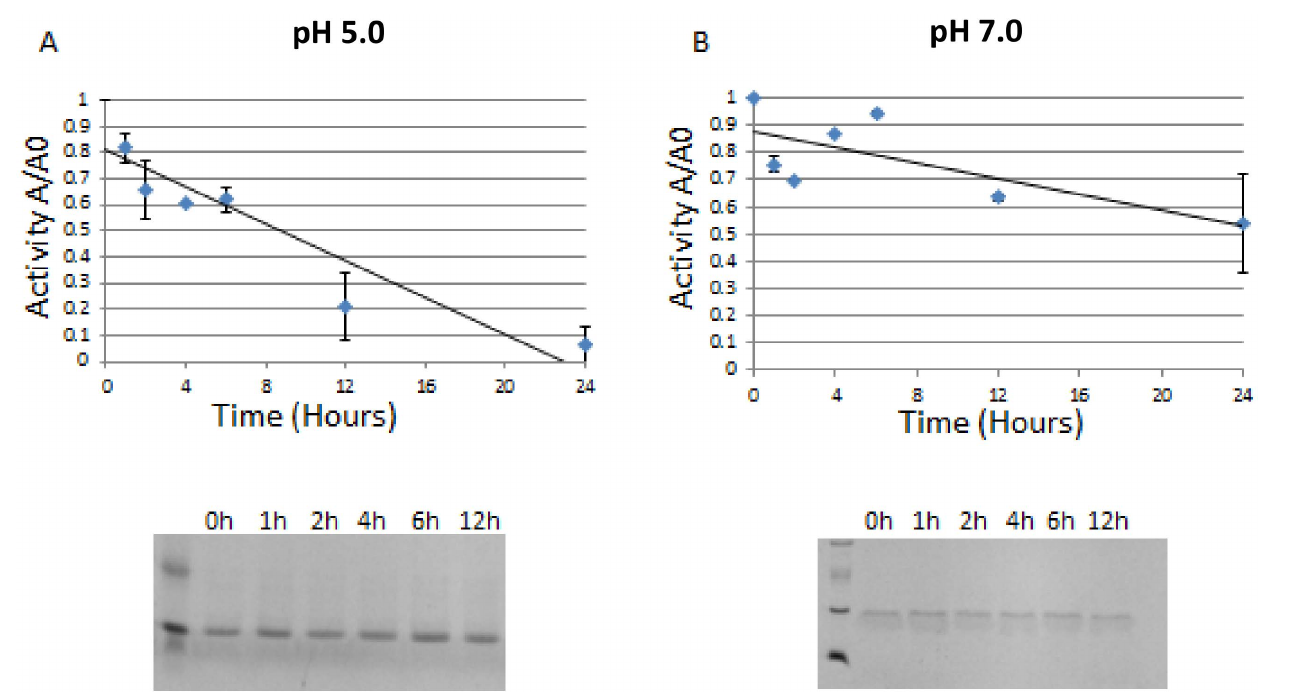
Figure 6. Studies on autodegradation of HIV-2 protease. A : autodegradation analysis in a buffer composed of 50 mM sodium acetate and 50 mM sodium chloride (pH 5.0). B : autodegradation in buffer D (pH 7.0). X axis represents the incubation time in hours, Yaxis represents A/A0 the ratio of active protein A at a given time to the total active protein A0 at time 5 0. Autodegradation characterization was also performed on 16% SDS gel electrophoresis, the corresponding gel pictures are shown, the seemingly double banding seen in SDS-gel picture of B is due to artifact caused by the PR buffer composition.